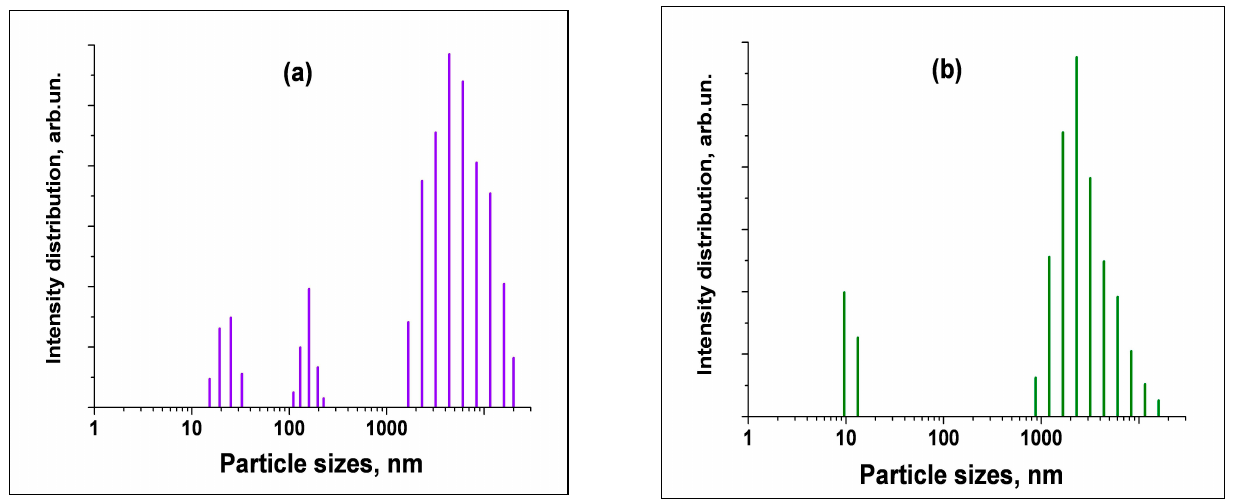
Figure 7. ( a ) Intensity distribution for sol prepared from Ru/HPS (violet).( b ) Intensity distribution for sol prepared from Pd/HPS (green).